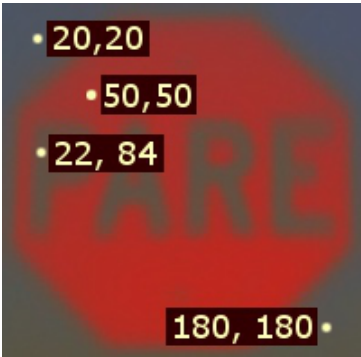
Figure 7. Representative points of a stop sign template obtained by averaging reference samples in the ErEgEb